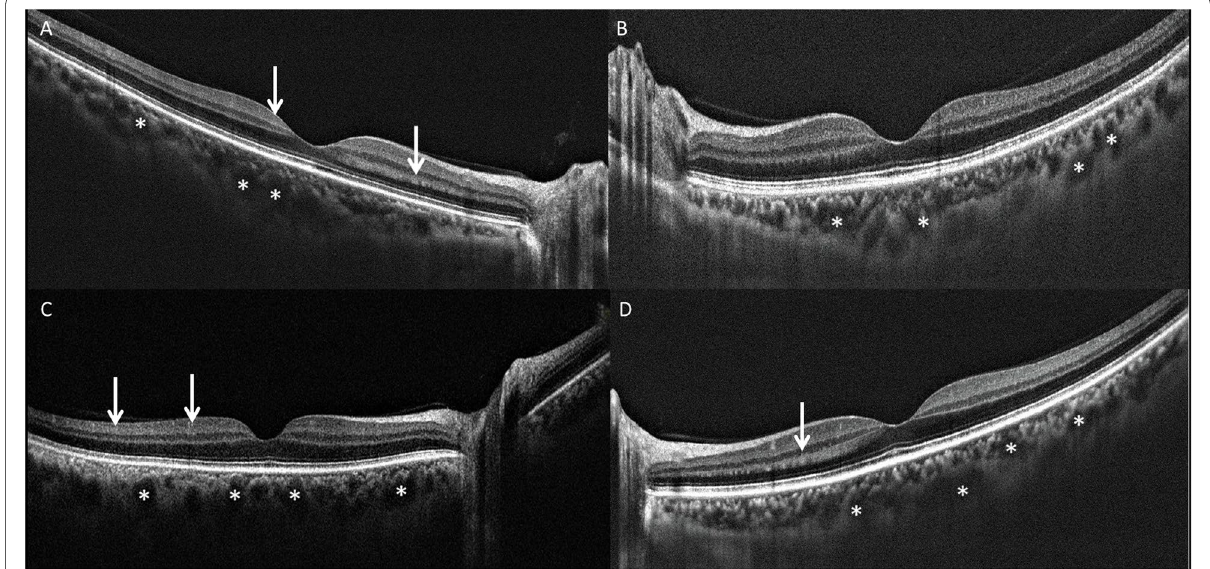
Fig. 1 Spectral domain optical coherence tomography finding of macular area in a representative patient with coronavirus disease 2019. Note the hyperreflective bands in different retinal layers (white arrows) and dilated choroidal vessels